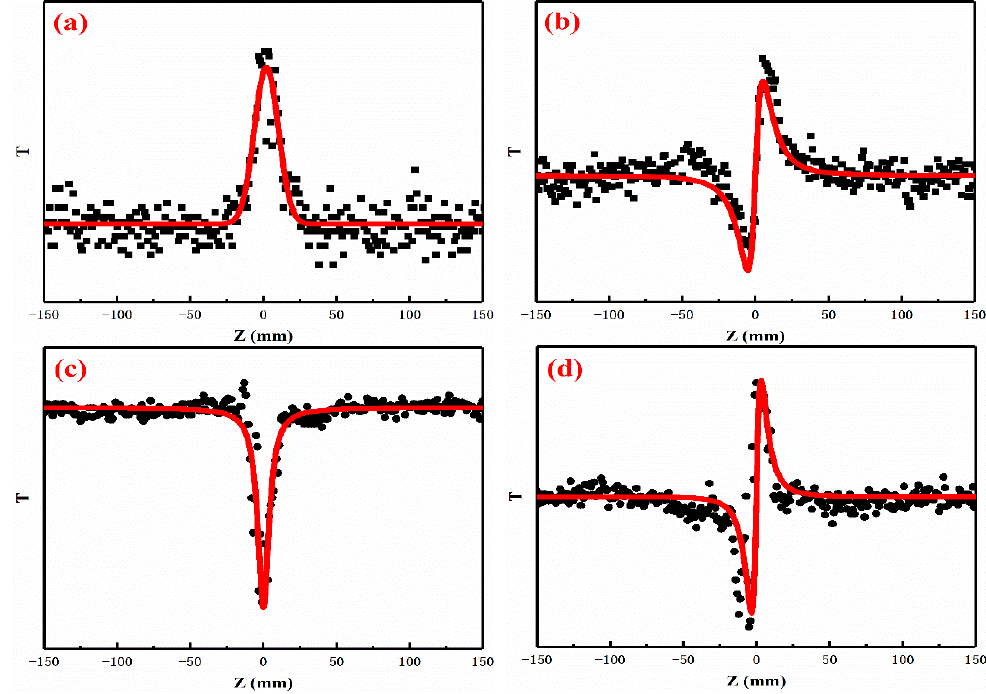
Figure 9. ( a , b ) OA and CA curve of RGO, ( c , d ) OA and CA curve of CdSe/RGO-1:2 composites.